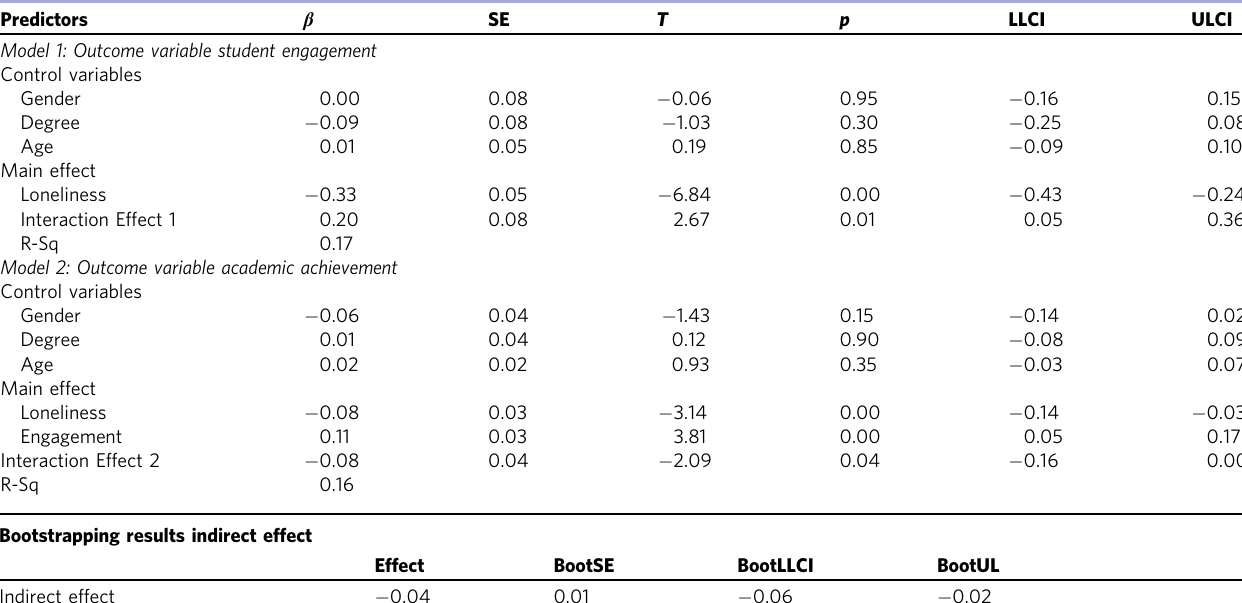
Table 4 Hypotheses evaluation (model 8 of Hayes ’ PROCESS